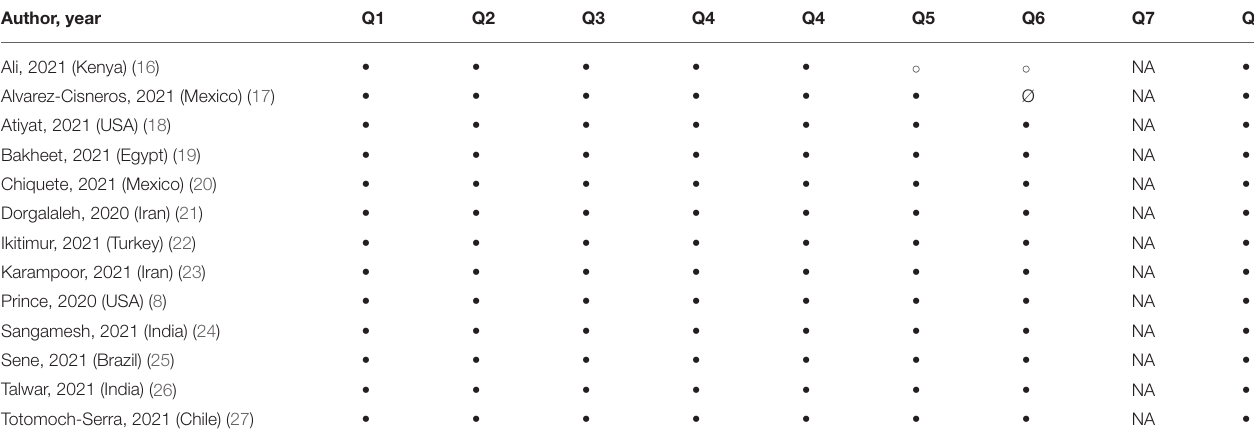
TABLE 2 | Quality assessment of the included